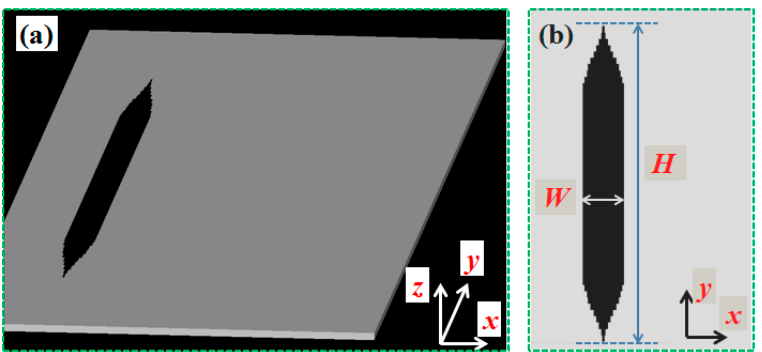
Figure 1. Schematic diagrams of the designed plasmonic device capable of generating flat top SPP beams, ( a ) three-dimensional configuration, with the height of h o = 150 nm in z axis, ( b ) two-dimensional configuration. The black area indicates the cross-section shape of the groove that etched in the metallic silver film. W and H indicate the maximum length of the groove along x and y axis, respectively.